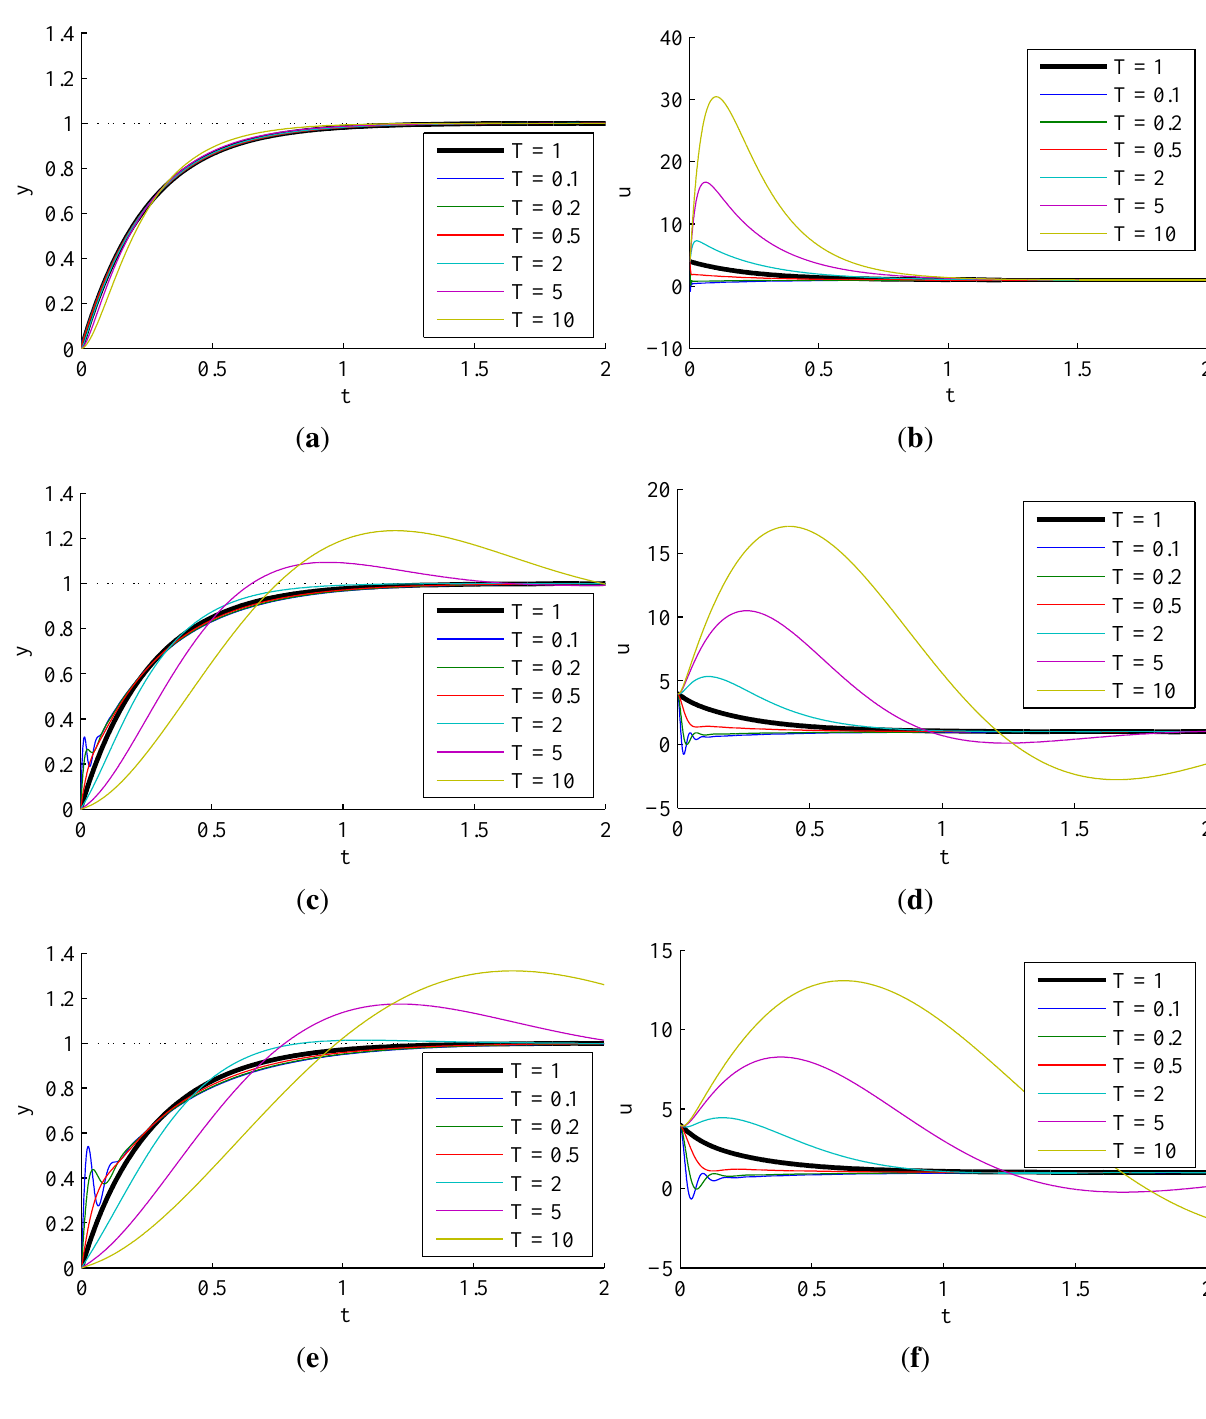
Figure 4. Experiment 3.1.2: effect of pole locations for the extended state observer (ESO) on a fixed first-order ADRC controlling first-order process with varying parameter, T .